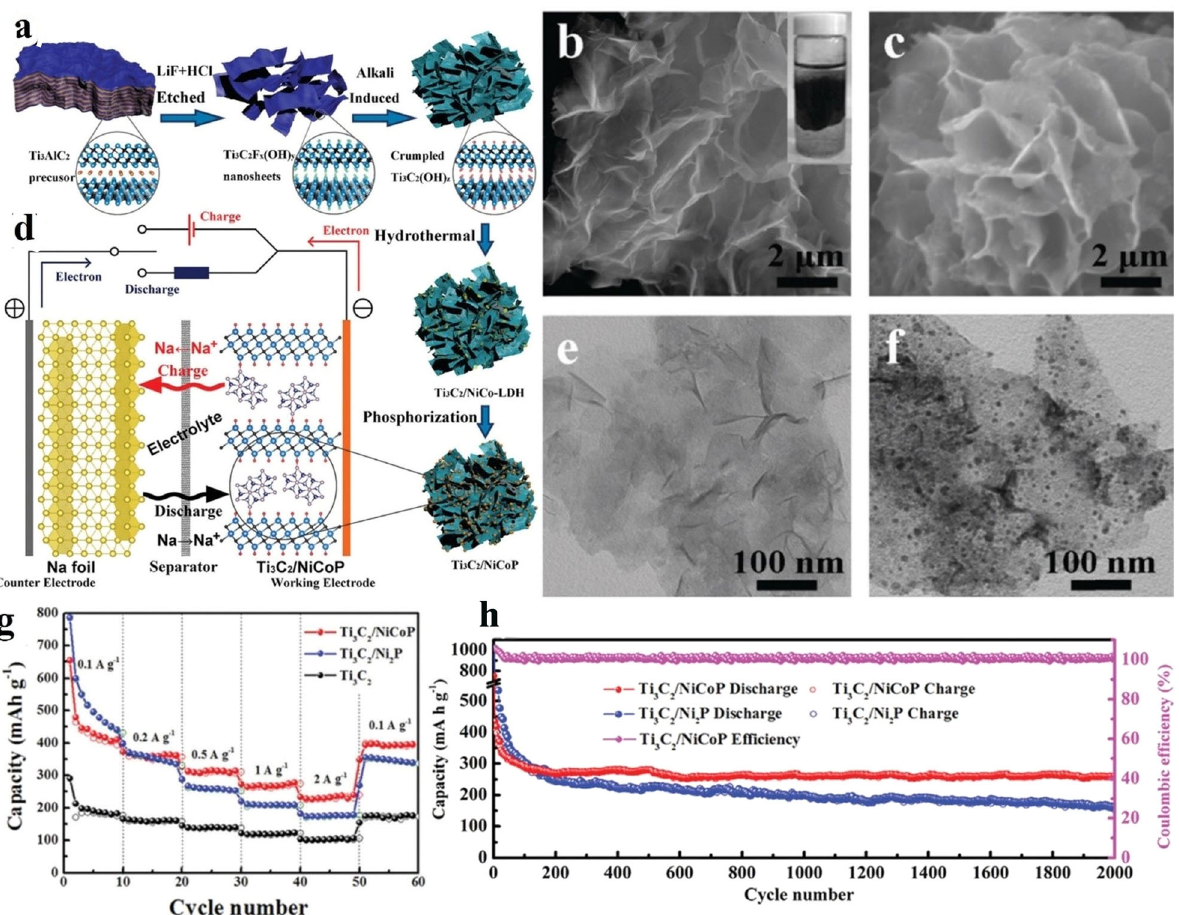
Fig. 12 Performance of Ti 3 C 2 /NiCoP hybrid material. a Step-wise schematic representation of the synthesis process of the Ti 3 C 2 /NiCoP hybrid. b , c FESEM images of the wrinkled Ti 3 C 2 alkali-induced 3D and the composite network of Ti 3 C 2 /NiCoP, respectively. d Schematic charge-discharge process in half-cells. e , f TEM micrographs of the alkali-decorated 3D Ti 3 C 2 hybrid and the Ti 3 C 2 /NiCoP composite, correspondingly. g Ti 3 C 2 , Ti 3 C 2 /Ni 2 P, and Ti 3 C 2 /NiCoP electrodes ’ rate capability. h Cycling performance of Ti 3 C 2 /Ni 2 P, and Ti 3 C 2 /NiCoP electrodes at a current density of 1.0 A g -1 after 2000 cycles. Reprinted with permission from 152